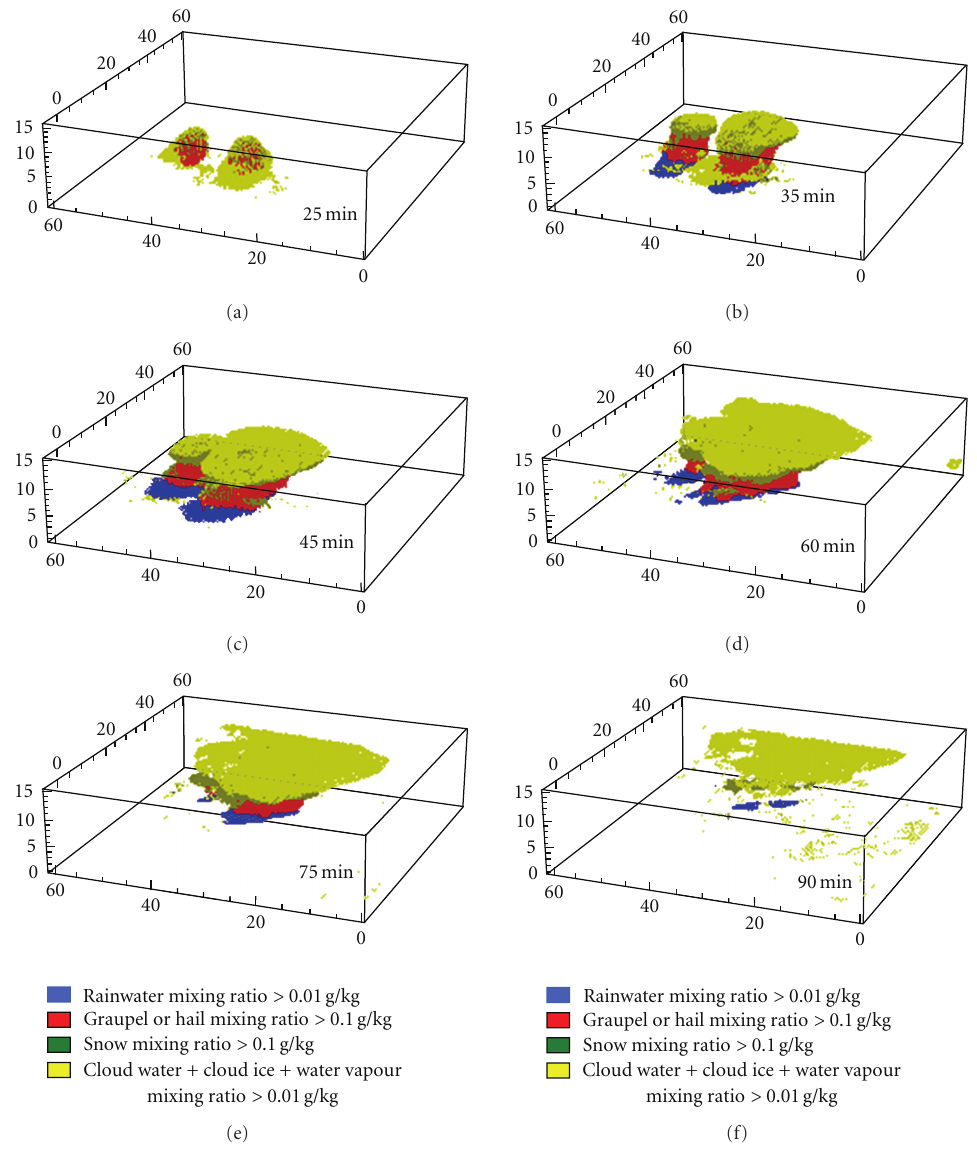
Figure 3: The same as Figure 2 except that the model was set up with a finer spatial resolution of (0 . 5 × 0 . 5 × 0 . 250) km 3 and temporal resolution of 5s. Table 1: Comparison between modeled and observed parameters. Columns shown from left to right illustrate UTC time of radar observation, consistent model simulation time, liquid water content, updraft speed, cloud top, radar reflectivity, and rainfall intensity averaged over simulation